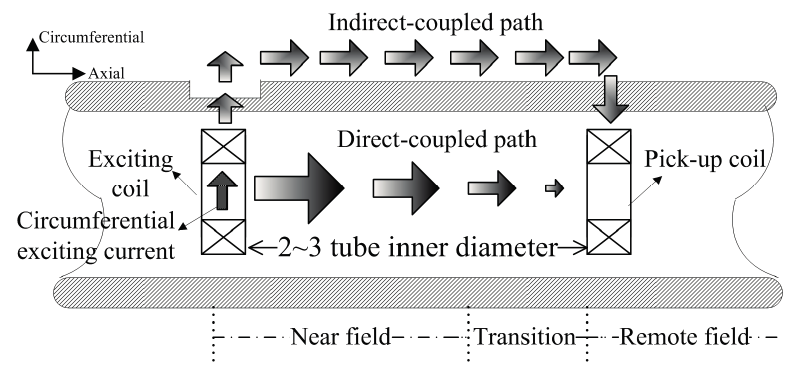
Figure 1. Principle of remote field eddy current